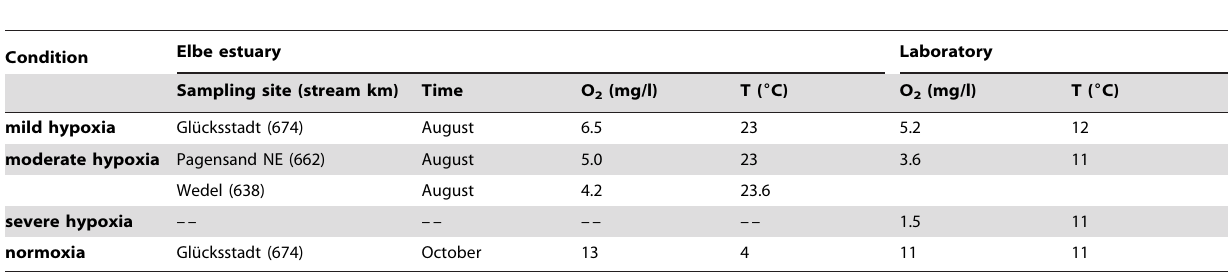
Table 1. Comparison of oxygen concentrations in the Elbe estuary and in laboratory experiments.